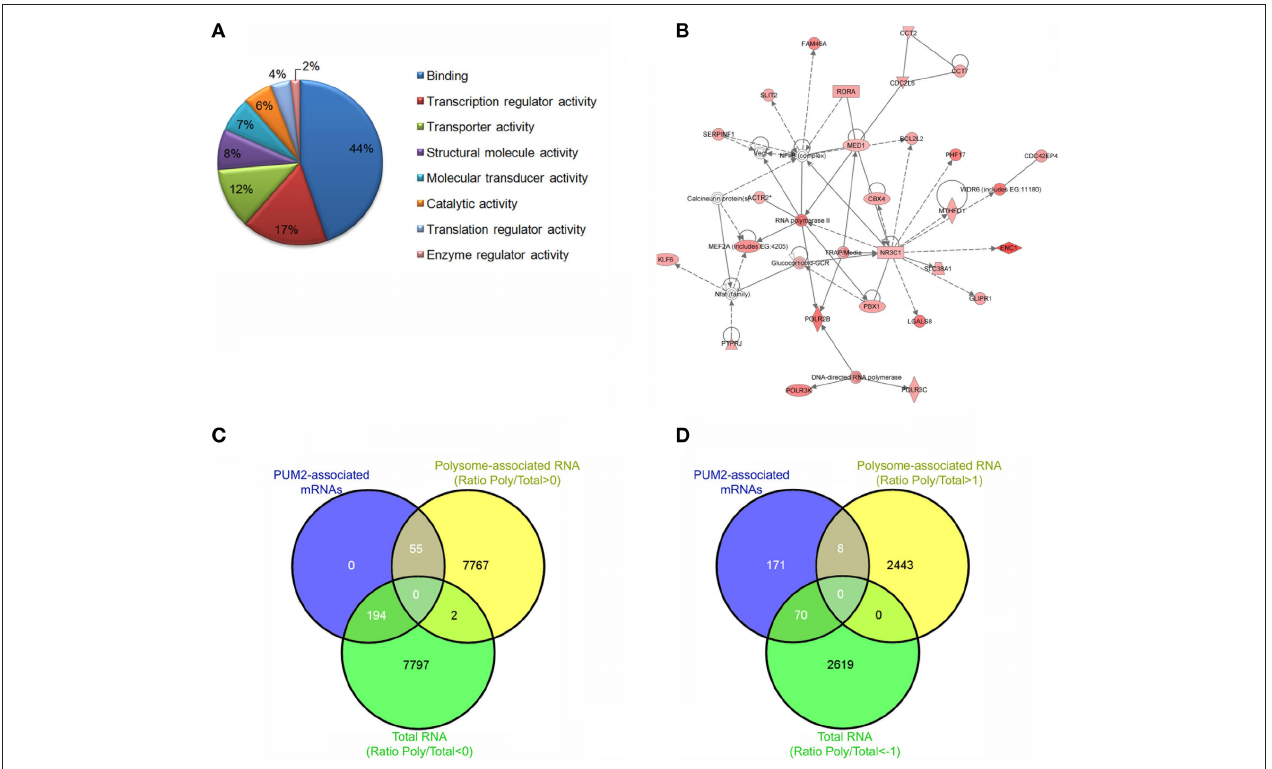
FIGURE 2 | Steps to Ribonomic analysis of PUM2-associated mRNAs. Ensure that the protein of interest was specifically immunoprecipitated using western blotting. Identify and cluster the mRNAs according to their enrichment and the biological and technical replicates. (A) Cluster the mRNAs according to biological process, cellular component, and molecular function. (B) Identify networks of mRNAs that are associated with PUM2. (C) Comparison of the PUM2-associated mRNAs with Total RNA (ratio < 0) and polysome-associated mRNAs (ratio > 0). Ratio polysome-associated RNAs/Total RNA. (D) Comparison of the PUM2-associated mRNAs with Total RNA and polysome-associated mRNAs enriched < 1 and > 1,